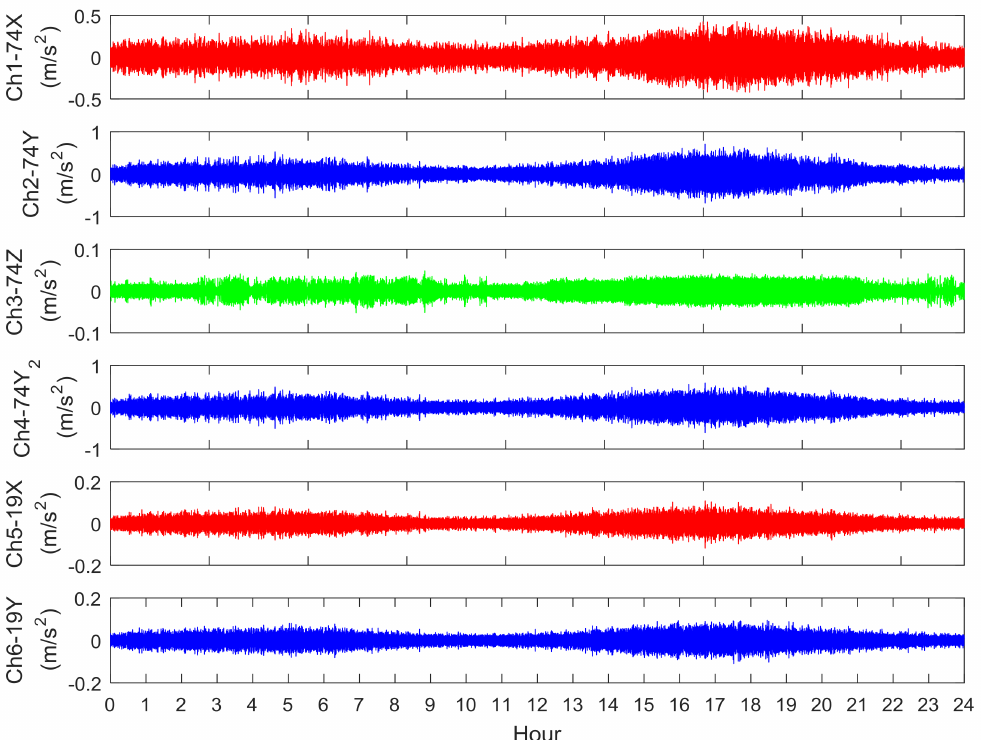
Figure 5. Time-series of acceleration data on 1 June 2016.